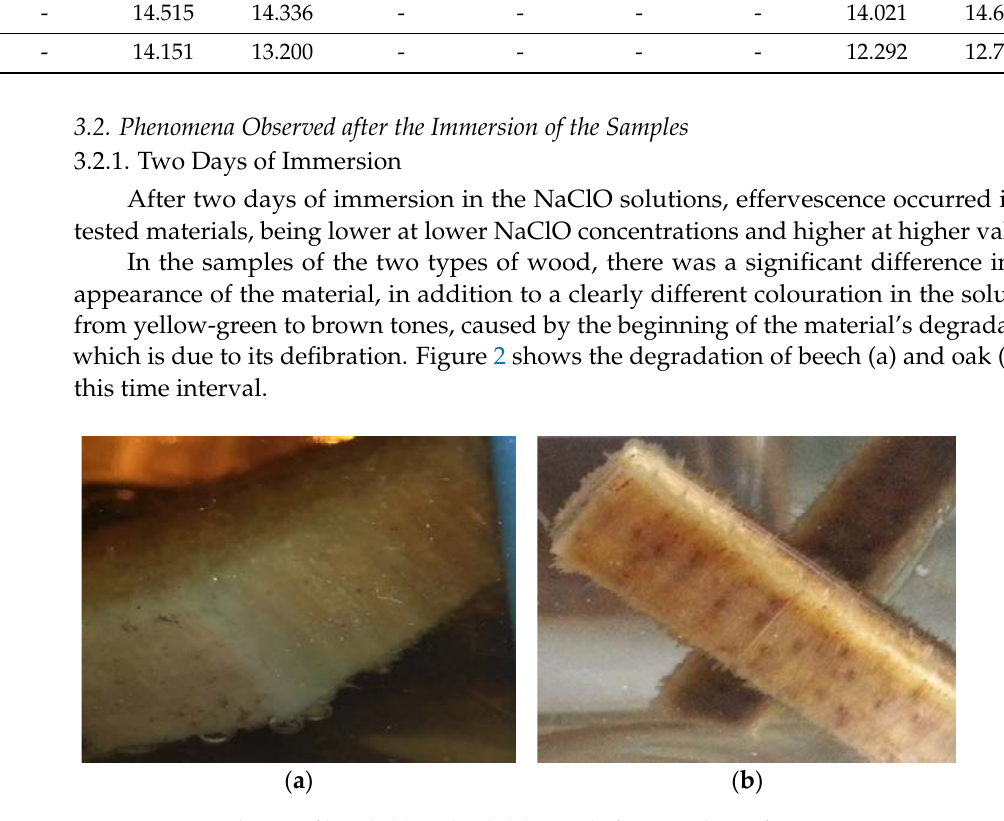
Figure 2. Degradation of beech ( a ) and oak ( b ) wood after two days of immersion